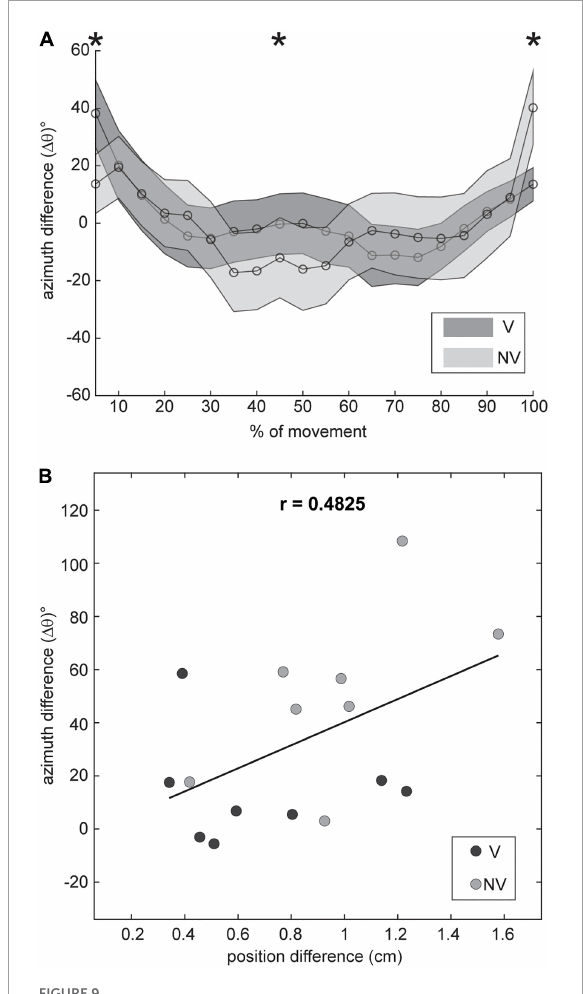
FIGURE9 (A) Mean within-participant differences in azimuth between arm postures ( ± SE), plotted as a function of movement extent for both feedback conditions. Data were smoothed with a low pass filter prior to plotting. Statistically significant, posture dependent differences in azimuth (*) were evident very early (5%), near the midpoint of the movements (45%) and at the endpoint (100%). (B) Azimuth differences at the endpoint plotted against differences in mean endpoint position for each participant. Differences in azimuth were moderately correlated with differences in mean endpoint